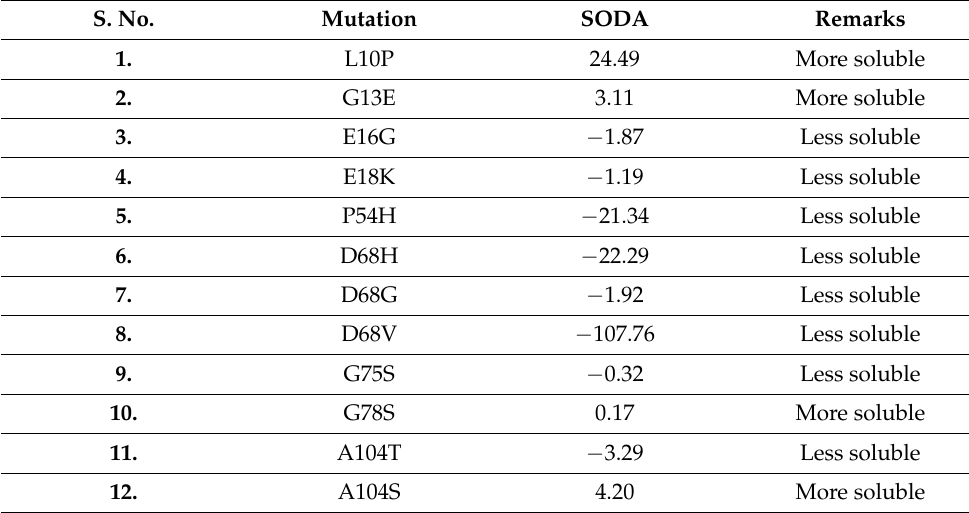
Table 3. Aggregation propensity prediction of PARK7 mutants with the help of